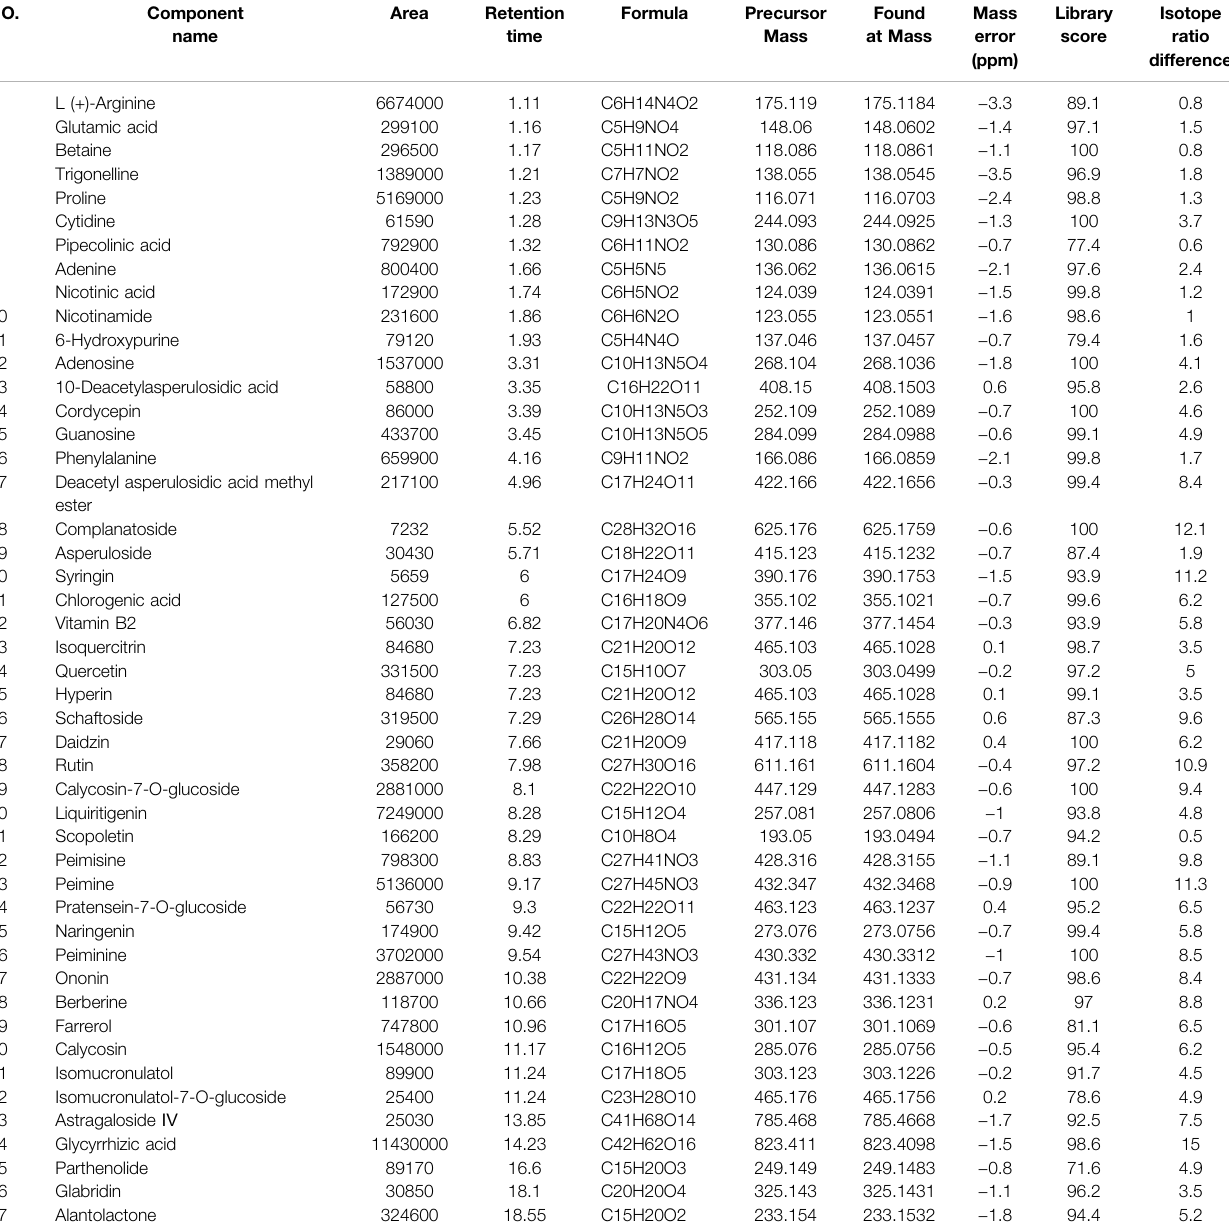
TABLE 1 | Putative identi fi cation of MSJZD in positive ion mode.